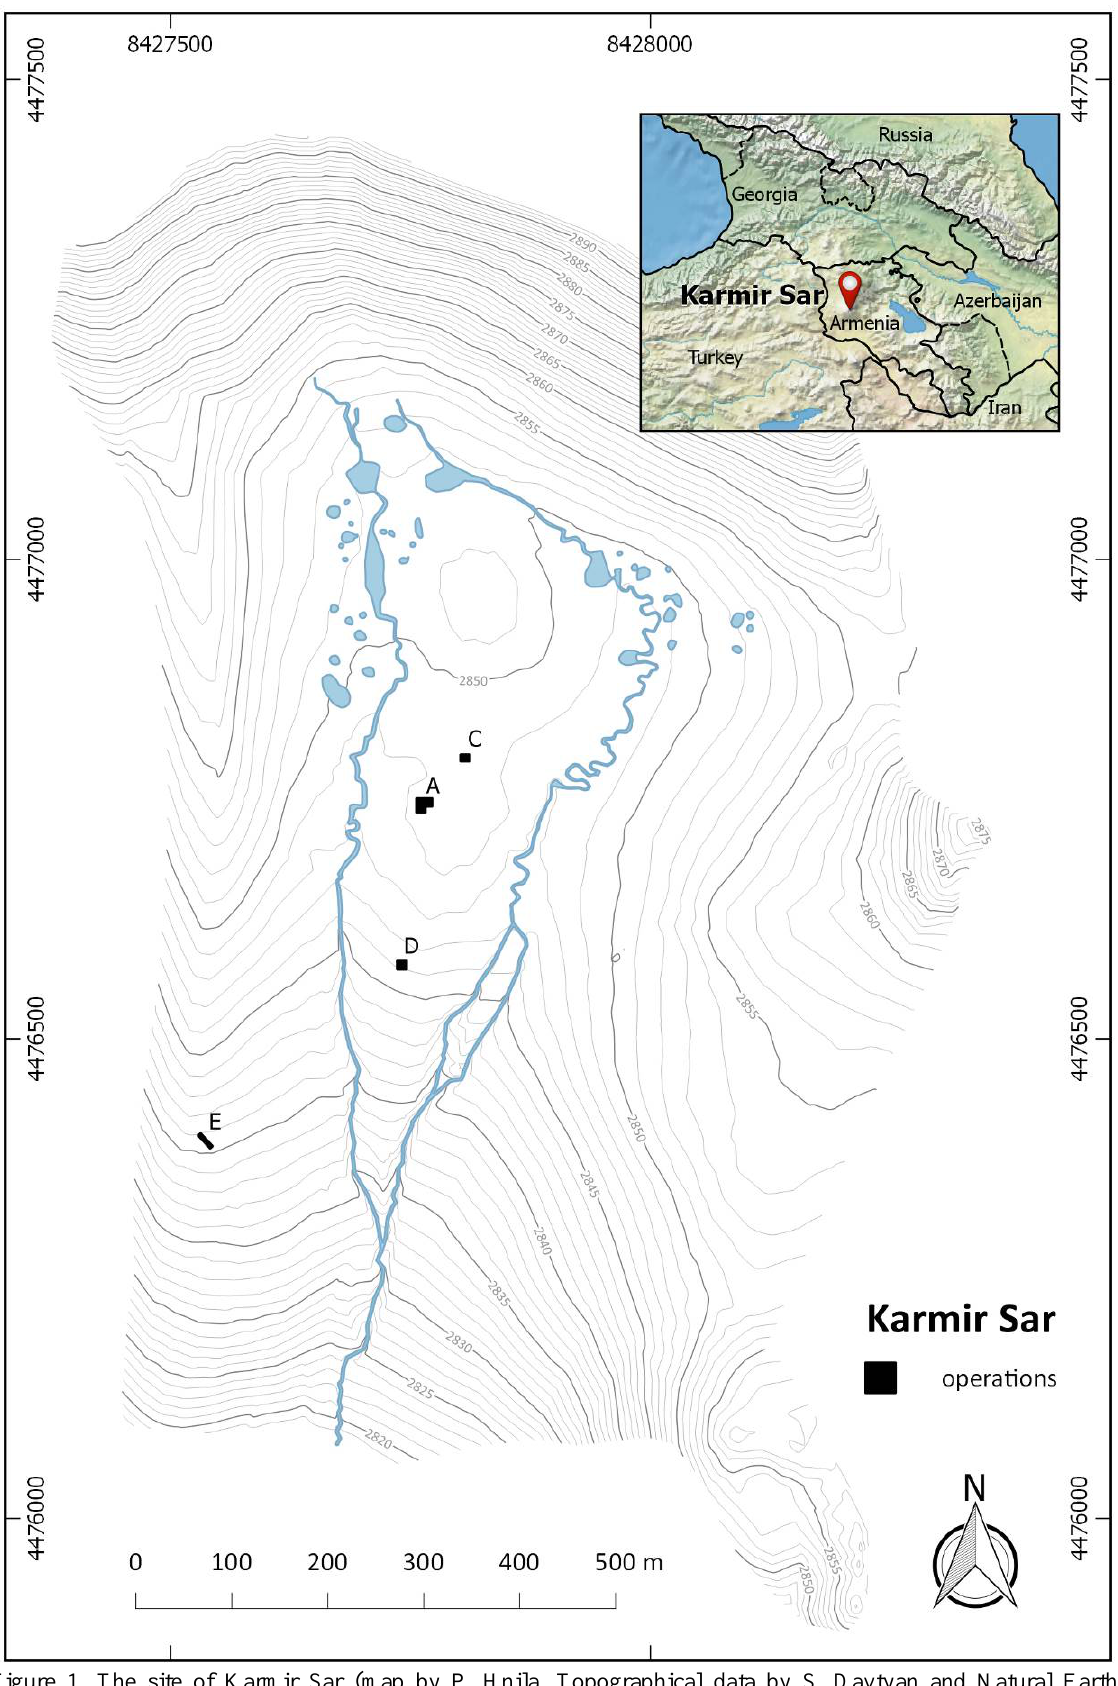
Figure 1. The site of Karmir Sar (map by P. Hnila. Topographical data by S. Davtyan and Natural Earth. Projection: Pulkovo42/Gauss-Kruger Zone